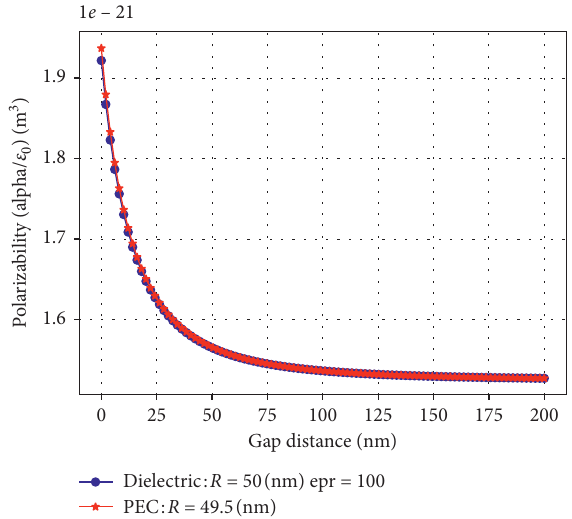
Figure 4: Relationship between the polarizability of the radius 50nm dielectric sphere with dielectric constant 100 and the radius 49.5nm metal sphere and the distance from the surface of the